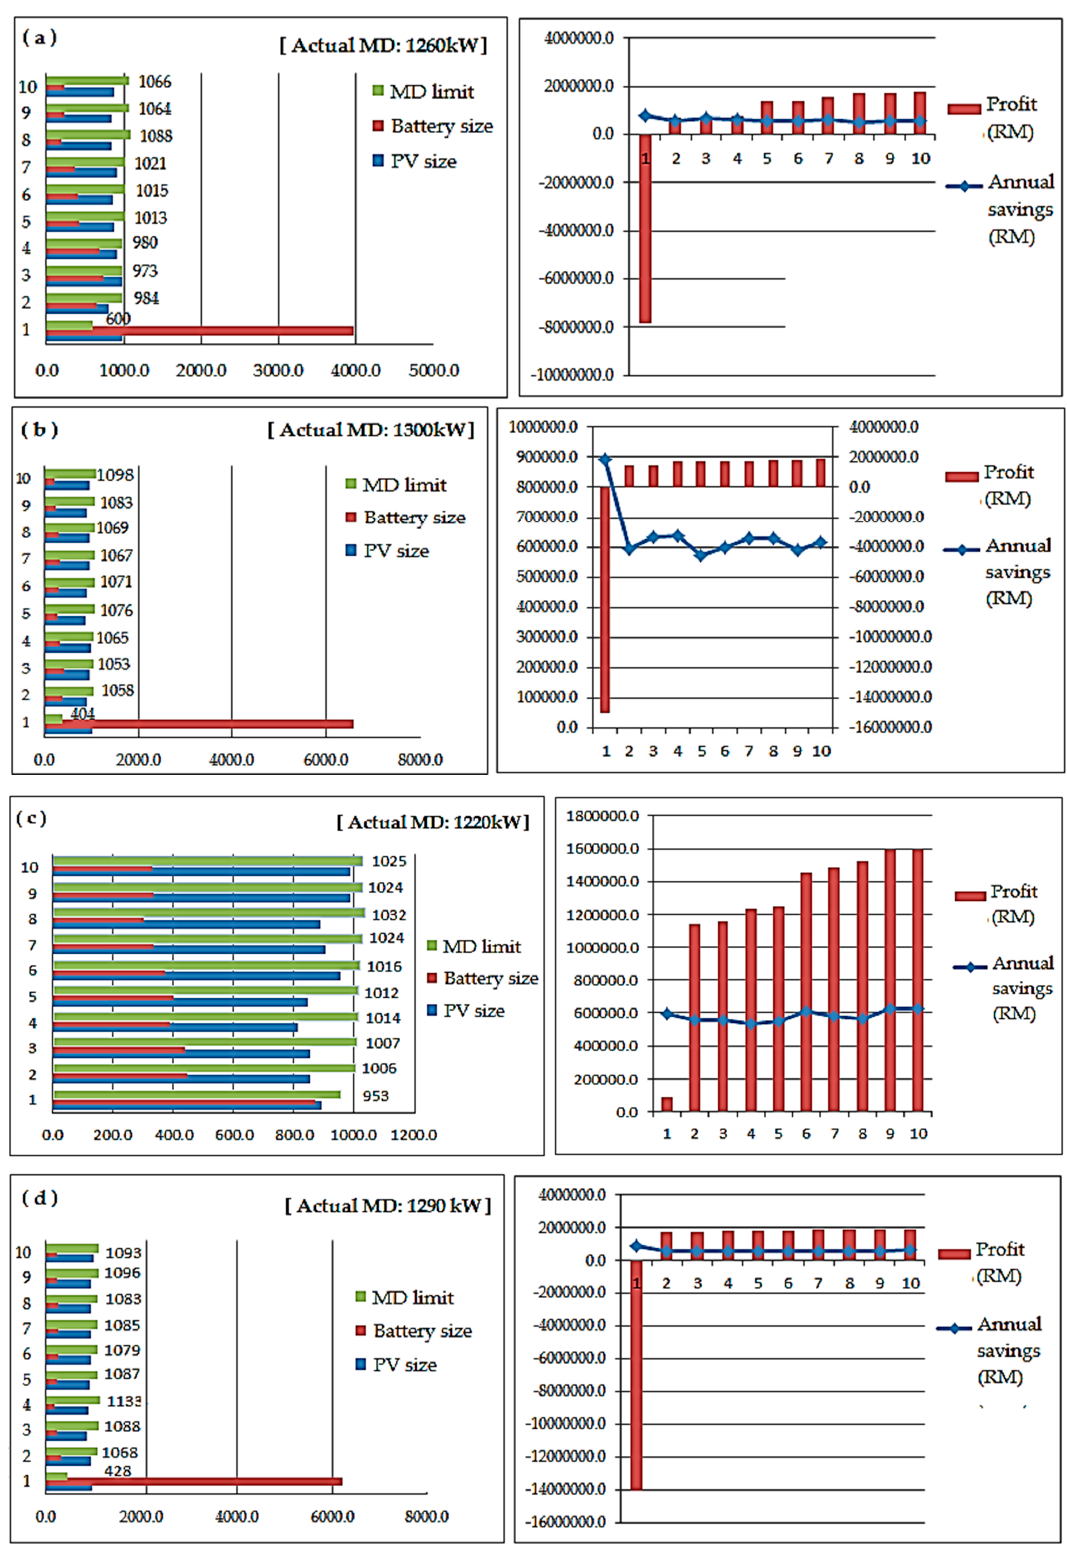
Figure 8. Percentage of energy savings based on load profile.